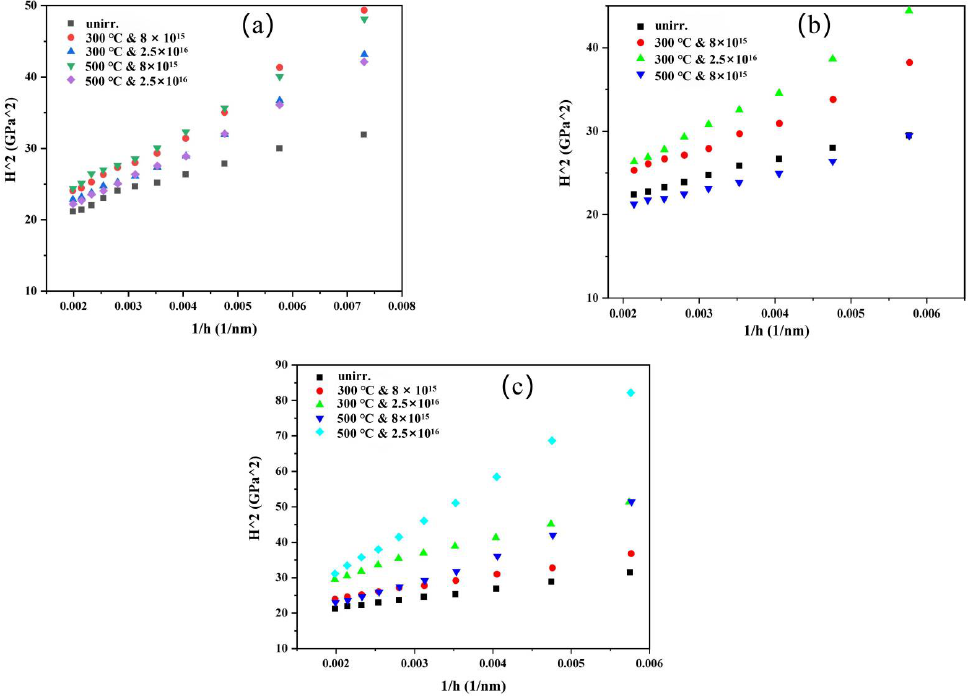
Figure 7. Nix–Gao model for three MEAs before and after Fe 11+ irradiation: ( a ) Zr 40 Nb 35 Ti 25 , ( b ) Zr 50 Nb 35 Ti 15 , and ( c ) Zr 60 Nb 35 Ti 5. Table 5 illustrates the results of irradiation hardening and the hardening rate on the alloy. The results show the hardness value after irradiation with a high dose and high temperature are to varying changes, some materials increased, and others decreased after irradiation, but the overall pattern is still hardening. Several factors could cause irradia- tion-hardening, including the radiation-induced precipitation (RIP) and the formation of dislocation loops [39]. Additionally, it has been reported that the visible dislocation loops are the main contributor to the irradiation hardening of HEAs at room temperature [40,41]. As far as we know, this is firstly showing a softening of the BCC single-solution MEAs after irradiation.